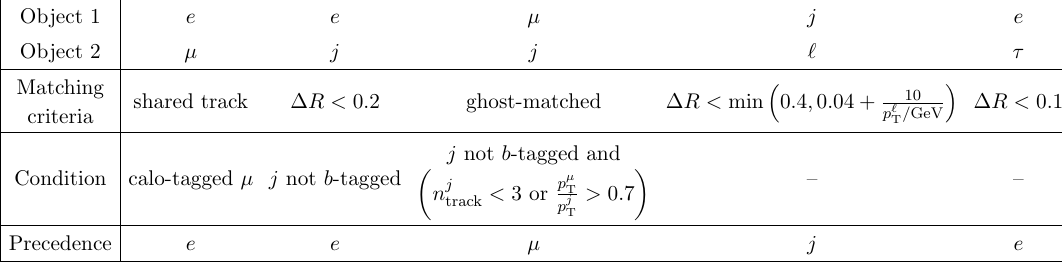
Table 3 . Overlap removal procedure for physics objects. The (cid:12)rst two rows list the types of overlapping objects: electron ( e ), muon ( (cid:22) ), electron or muon ( ‘ ), jet ( j ), and hadronically decaying (cid:28) lepton ( (cid:28) ). All objects refer to the baseline de(cid:12)nitions, except for (cid:28) where no distinction between baseline and signal de(cid:12)nition is made. The third row speci(cid:12)es when an object pair is considered to be overlapping. The fourth row describes an optional condition which must also be met for the pair of objects to be considered overlapping. The last row lists the object given precedence. Object 1 is retained and Object 2 is discarded if the condition is not met, and vice versa. More information is given in the